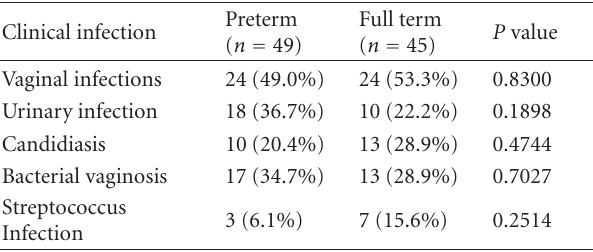
Table 2: The prevalence of urogenital infection in PTL and FTL